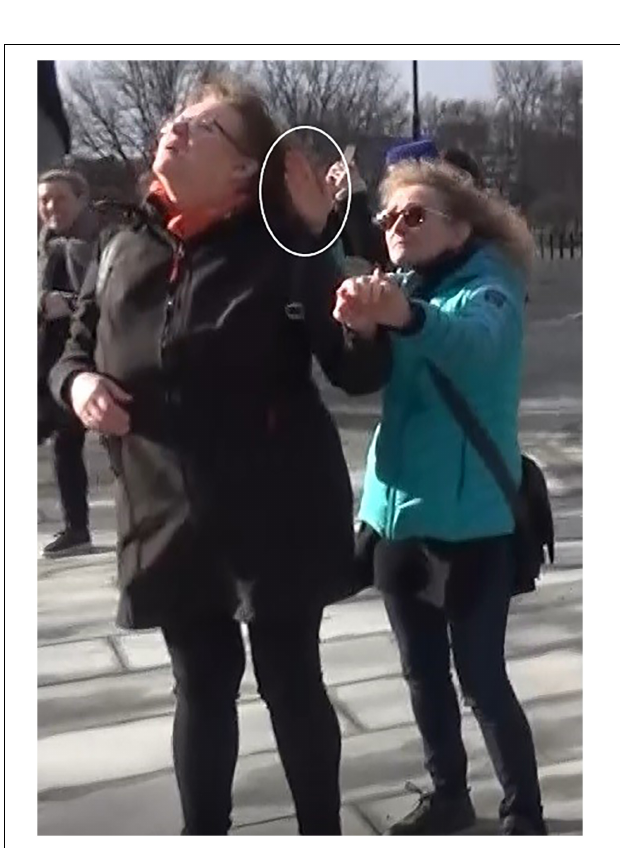
FIGURE 2 | Locative point on TS001’s left